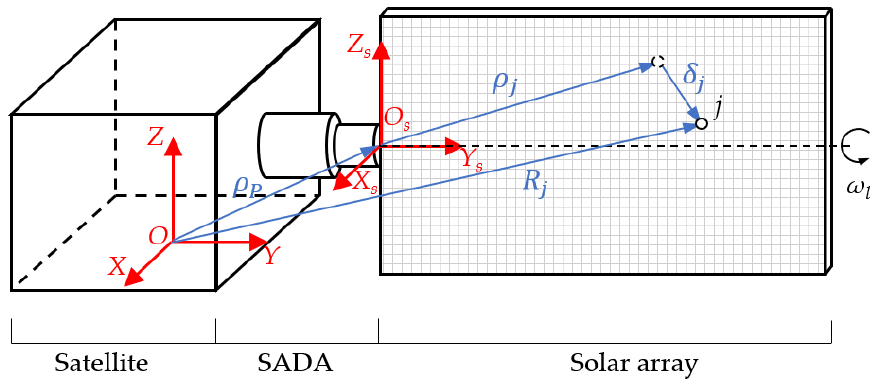
Figure 1. Schematic diagram of the solar array drive system .